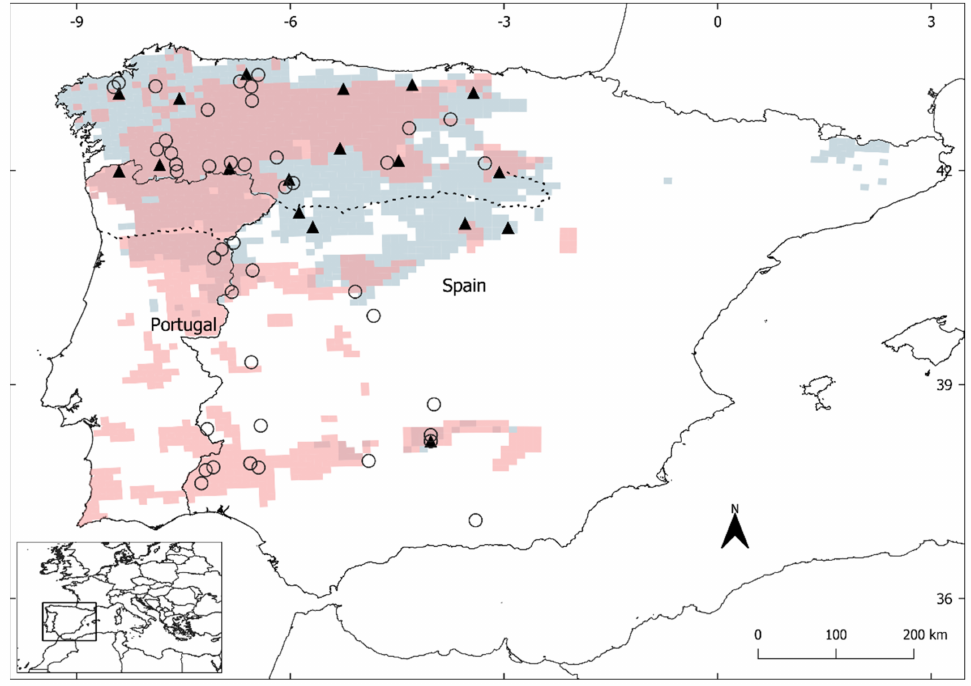
Figure 1. Sample distribution. Modern (filled triangles) and historical (empty circles) wolf specimens sampled throughout the current (gray; [34,35]) and historical (red; [52,53]) species distribution in the Iberian Peninsula. Dotted line marks the Douro River, which has been used for delimiting management units in Spain. Modern wolf data corresponding to the southern part of the distribution (Sierra Morena) was obtained from [32]. Data from the literature without precise locality information were not included in the figure (three historical specimens from Spain and eleven modern wolves, six from Portugal and five from Spain, see Tables 1 and